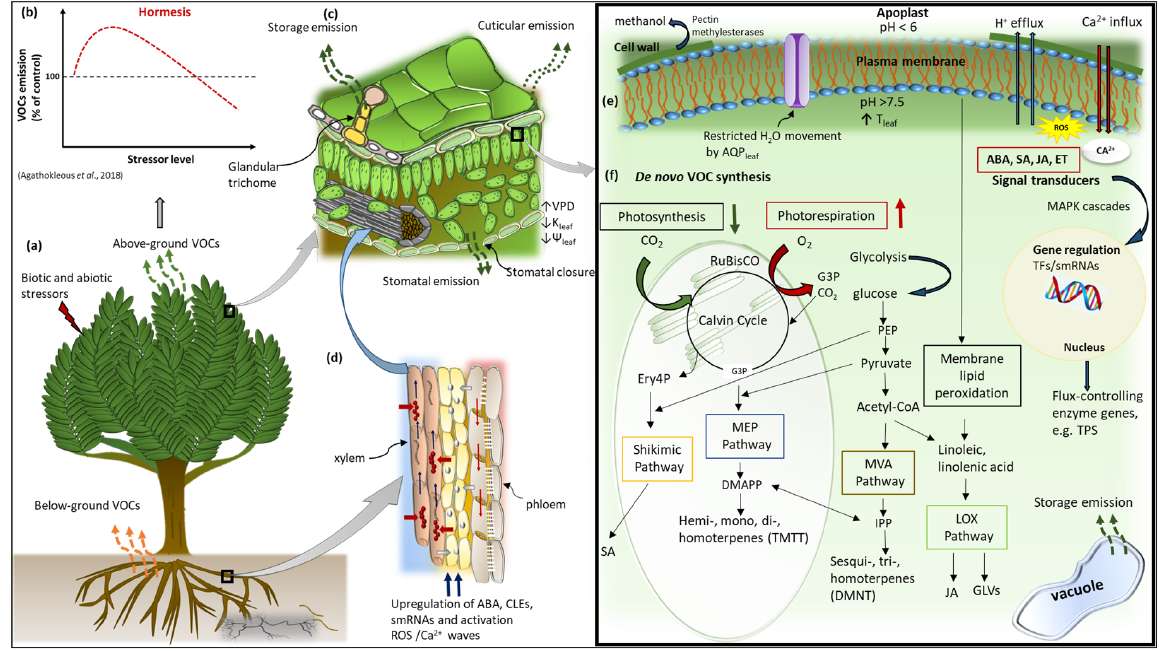
Figure 2. A simplified schematic of the interactions among major VOC biosynthesis pathways in response to stress. ( a ) VOC emissions respond to biotic and abiotic stresses from both below and aboveground sources of a plant. ( b ) A generalised VOC emission response to stress is given, which depicts a hormetic-like biphasic pattern. ( c ) Increased stress results in decreased intercellular CO 2 concentration favouring photorespiration over photosynthesis, which is the source of VOC precursors. ( d ) Various root-to-shoot signalling molecules that are involved in stress signalling. ( e ) Membrane depolarisation activities involving ROS accumulation and Ca 2+ influx as well as stress-induced phytohormones, e.g., ABA, JA, SA, and ET, activate defence signal transduction pathways that trigger gene expression of flux-controlling enzymes, e.g., TPS genes. Stressors affecting leaf temperature (T leaf ) influence the activity of the enzymes. ( f ) De novo VOC synthesis in the chloroplast and cytosol involves VOC precursors such as G3P (for the MEP pathway) and Ery4P (for the shikimic pathway), PEP from glycolysis, as well as its downstream metabolites pyruvate and acetyl-CoA that are involved in the Shikimic, MVA, and LOX biosynthesis pathways. Note that the sizes of organelles are not drawn to scale. Abbreviations: ABA, abscisic acid; JA, jasmonic acid; SA—salicylic acid; ET, ethylene; TPS, terpene synthase; G3P, glyceraldehyde 3-phosphate; MEP, 2-C-methyl- D -erythritol 4-phosphate; Ery4P, erythrose 4-phosphate; PEP, phosphoenol pyruvate; MVA, mevalonic acid; LOX, lipoxygenase; CLE25, CLAVATA3/EMBRYO-SURROUNDING REGION-RELATED 25; smRNA, small RNAs [114].